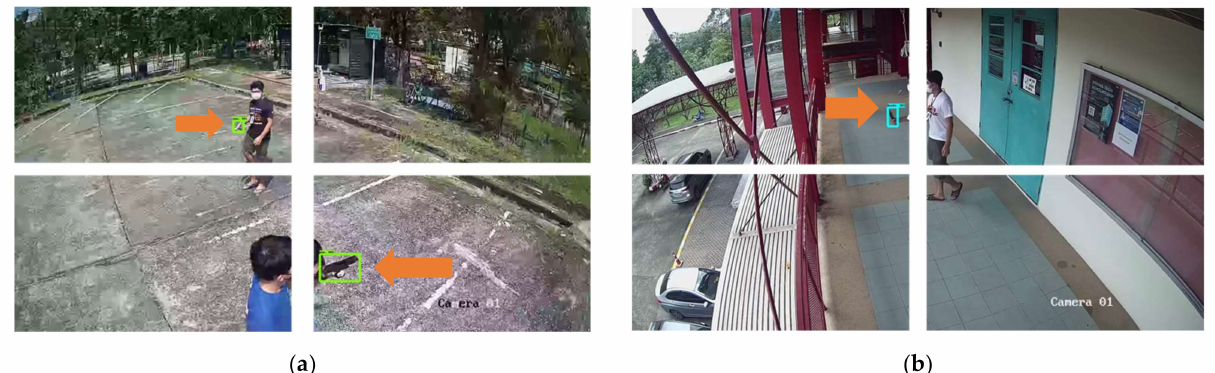
Figure 15. SSD MobileNet V2 model prediction on example images using Tiling Test Dataset 3 of ( a ) the same image of Tiling Test Dataset 1 and ( b ) the same image of Tiling Test Dataset